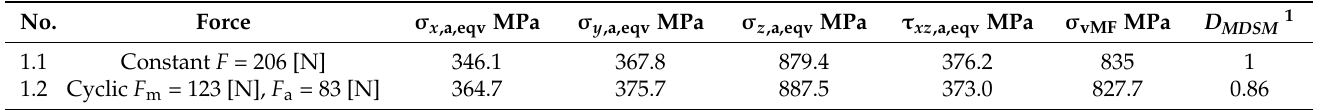
Table 4. Results obtained by using the modified spectral method (primary cycles) for a roller bearing subjected to constant and cyclic force.